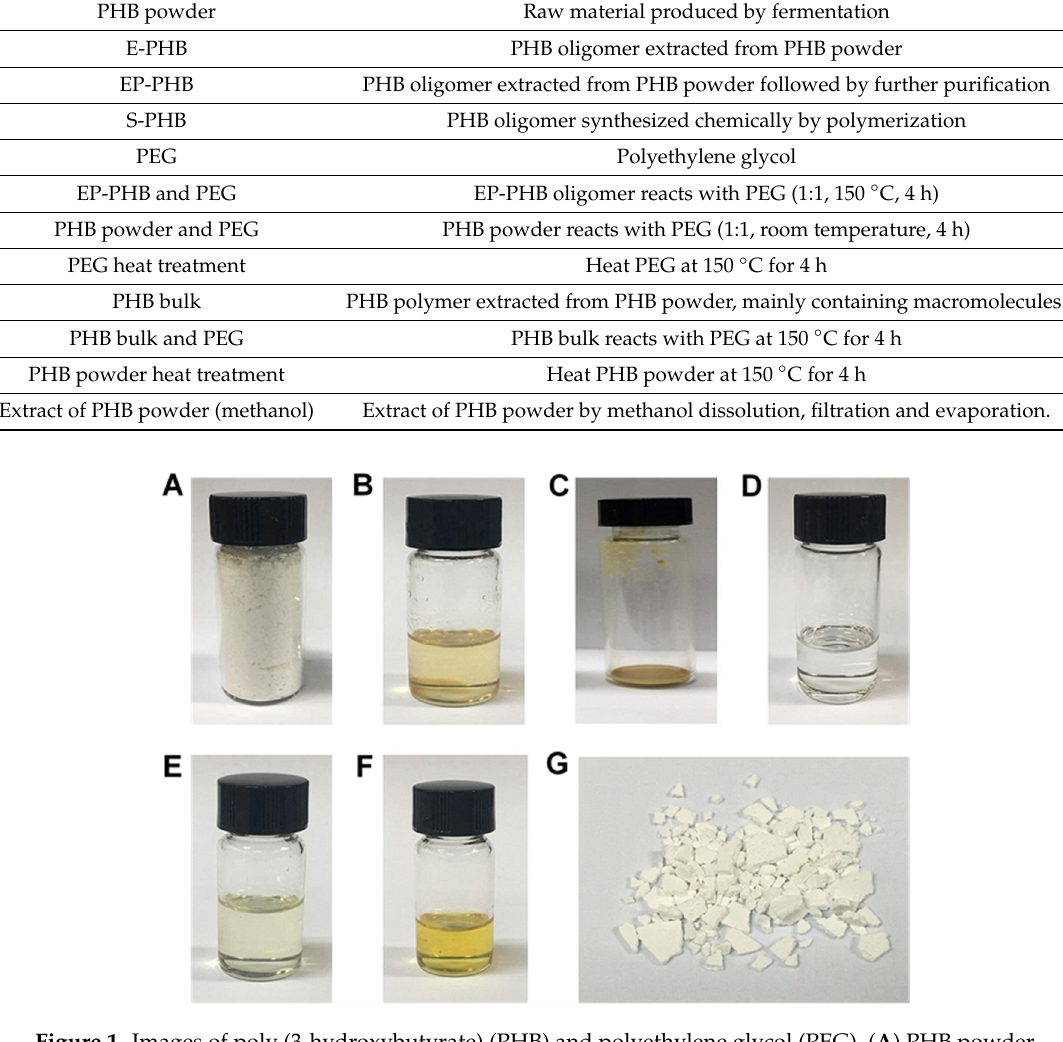
Figure 1. Images of poly (3-hydroxybutyrate) (PHB) and polyethylene glycol (PEG). ( A ) PHB powder. ( B ) synthesized poly (3-hydroxybutyrate) (S-PHB). ( C ) Extracted PHB (E-PHB) or extracted and purified PHB (EP-PHB). ( D ) PEG. ( E ) Liquid product of reaction of PHB powder and PEG under room temperature. ( F ) Liquid product of reaction of PHB powder and PEG under 150 °C. ( G ) PHB bulk. Table 2. Synergy between PHB oligomer and PEG.